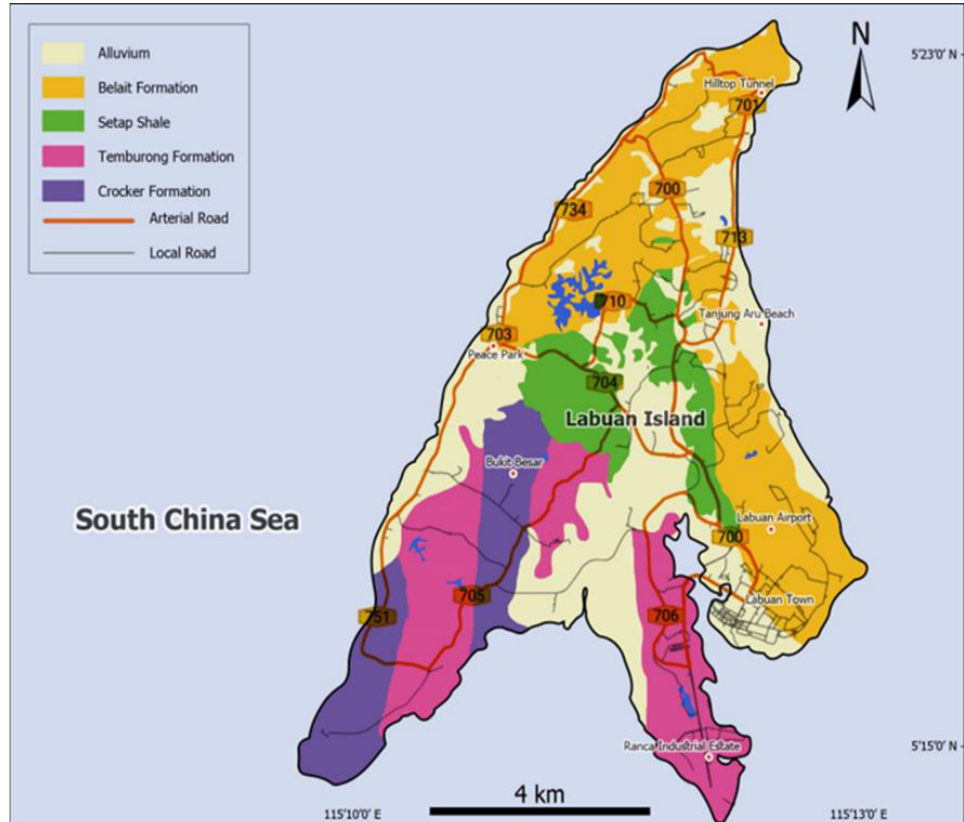
Figure 3. Labuan geological map, showing the distribution of the four major formations on the is- land [18]. the island